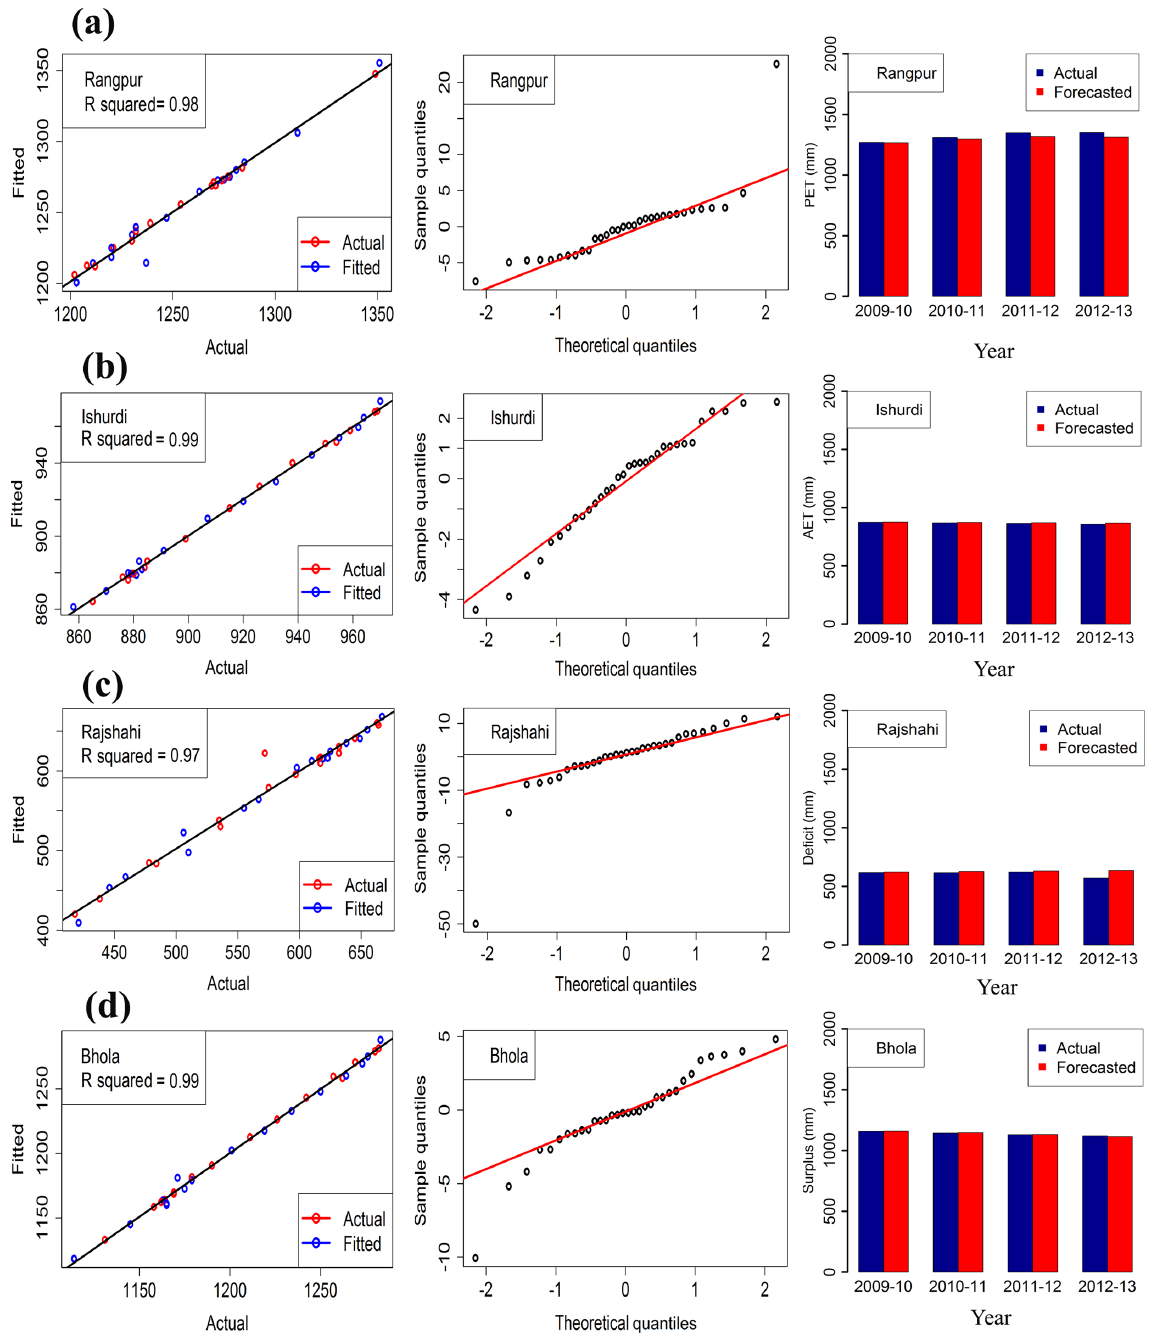
Figure 6. Plot of best WD-ARIMA model first panel represents actual versus fitted values for the period of 1981–1982 to 2012–2013, the second panel is normal Q – Q plot of residuals of the model, and the third panel shows actual, fitted, and forecasted values for 2009–2010 to 2012–2013. (a) P ET of Rangpur station located in the north, (b) A ET of Ishurdi station located in the central part, (c) deficit of Rajshahi station located in NW Bangladesh, and (d) surplus of Bhola station located in the south of the study